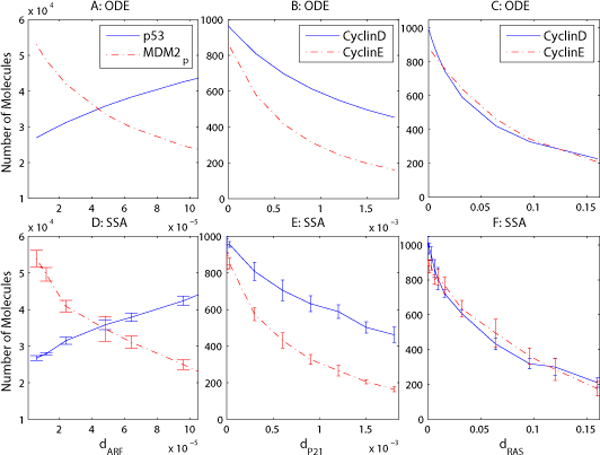
Mutations of ARF, P21 and RAS affect the cell's fate. Mutations of the tumor suppressor proteins ARF and P21, and of the oncoprotein RAS affect the cell's fate, using ODE (A-C) and stochastic (D-F) simulations. The mutations of ARF (A, D) and P21 (B, E), and RAS (C, F), which correspond to small dARF and dP21, and large dRAS values, upregulate the expression level of the oncoproteins MDM2 and CyclinD/E, and downregulate p53's expression level.